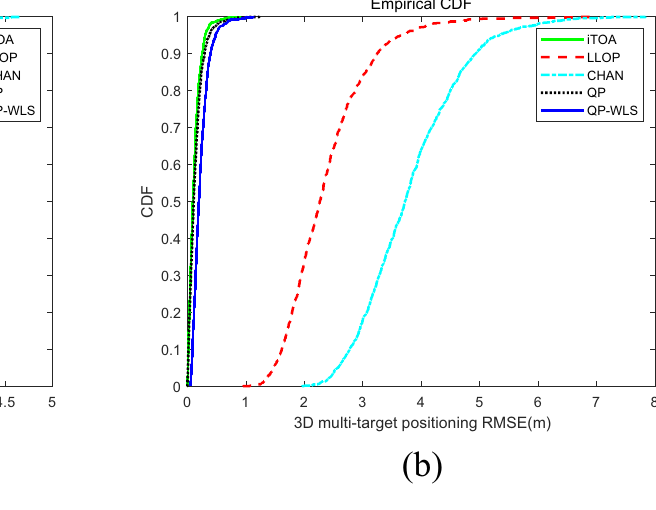
Figure 5: CDF of RMSE: ( a ) 2D CDF of RMSE and ( b ) 3D CDF of